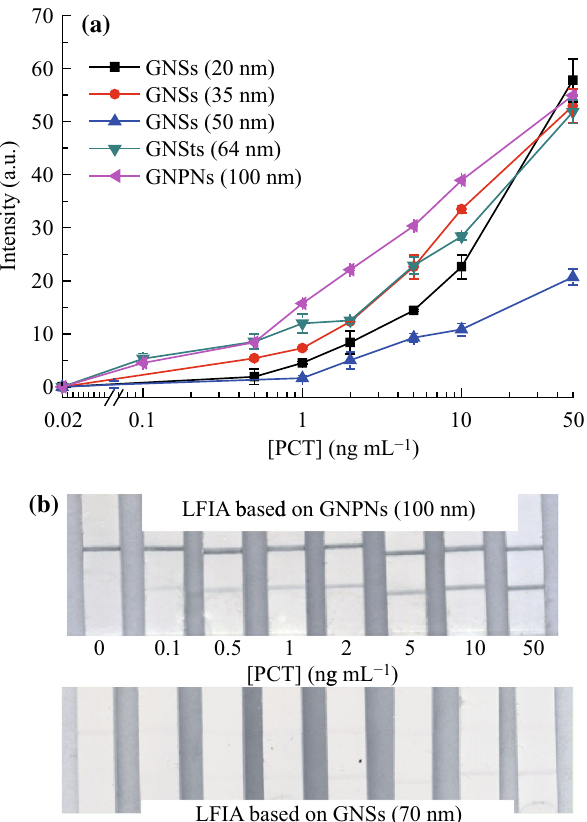
Fig. 5 a Calibration curves of LFIA for PCT detection based on GNSs, GNPNs, and GNSTs. b Color intensity in the analytical zone for GNPN-based and GNS-based LFIA (70